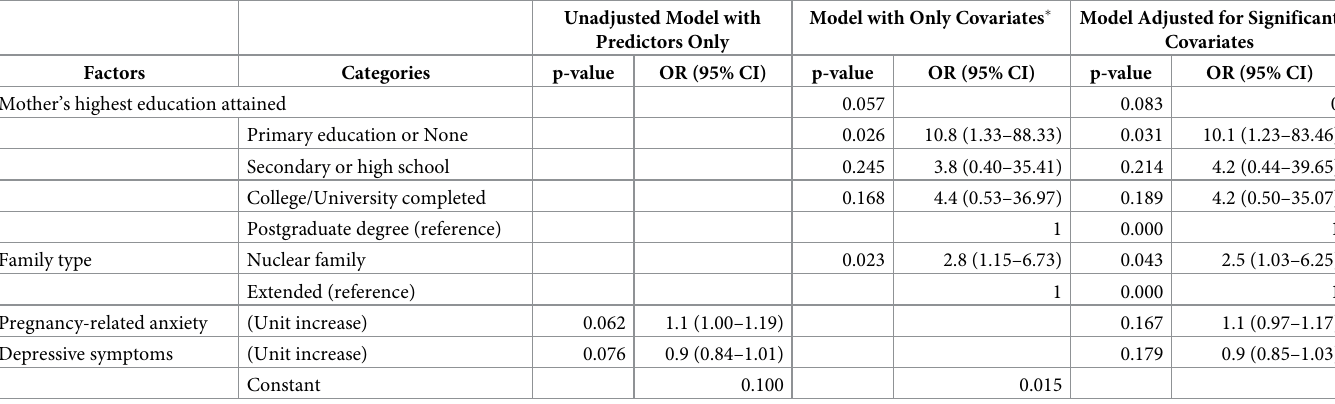
Table 2. Predictive model for preterm